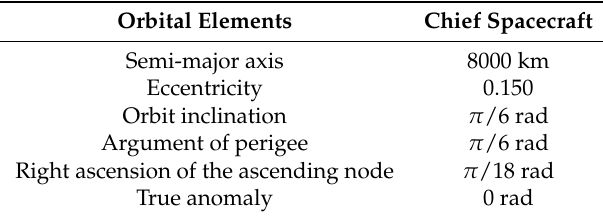
Table 3. Initial orbital elements of chief